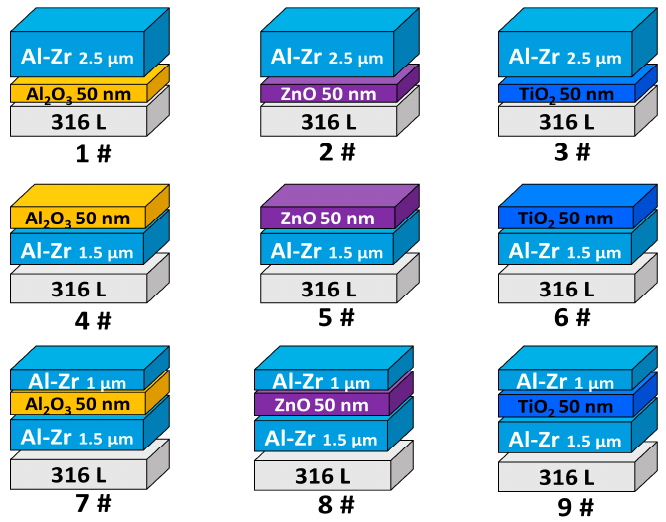
Figure 1. Schematic representation of different coatings architectures.